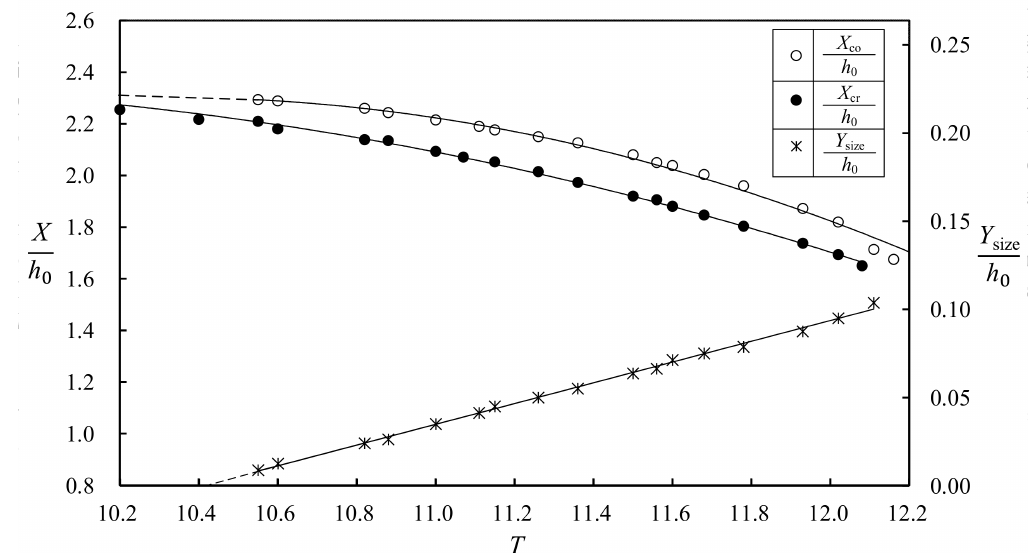
Figure 18. Variations in non-dimensional shoreward distances for critical and core sections as well as in non-dimensional size height (Case